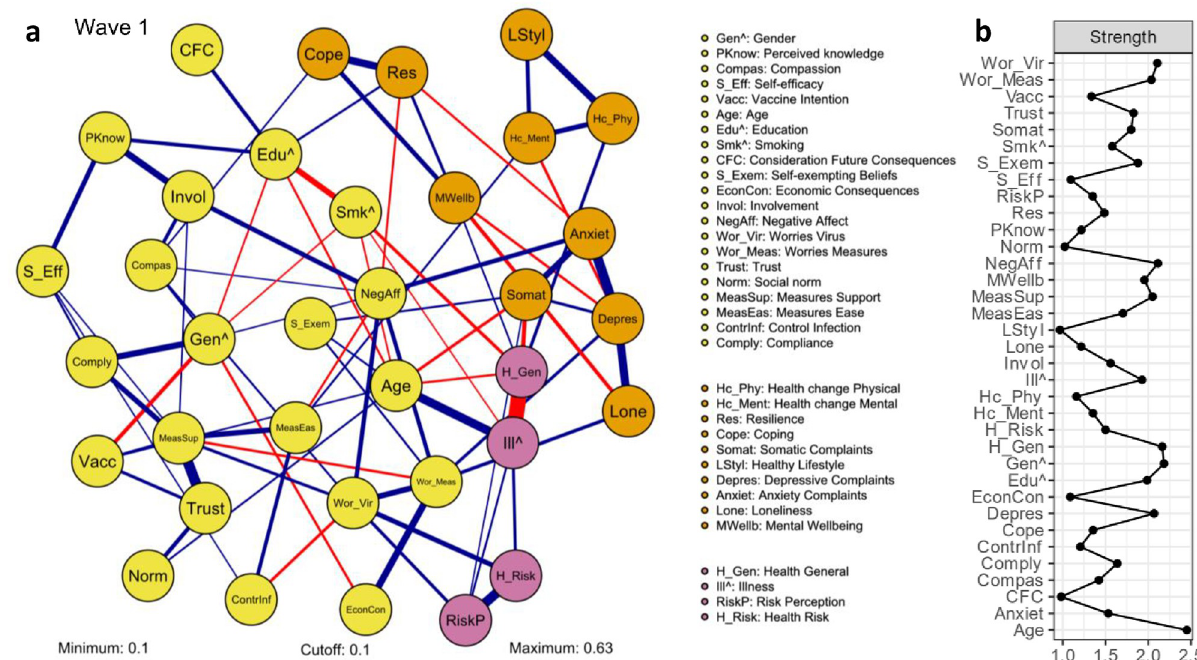
Fig 3. Psychological broad COVID–19 attitude network. a) Network obtained through nodewise regression, based on sample of participants that completed the first wave ( N = 6,093). Nodes represent the measured psychological factors and edges represent the relations between nodes. For binary nodes (marked with ^), a positive relationship indicates that increasing the other node results in a higher probability for category one of the binary node (i.e., Gender 1 = Female; Education 1 = Higher; Smoking 1 = Yes; Illness 1 = Yes). Positive edges (blue) represent excitatory relations and negative edges (red) represent inhibitory relations. The strength of the relation is indicated by the edge weight (visualized by edge width). Edges with edge weights below the value of .10 are omitted to facilitate readability. Colored groups represent communities (i.e., clusters with higher interconnectedness) consisting of nodes being more connected to each other than to other nodes in the network; b) Centrality measure ‘Strength’ for each node in the broad COVID–19 attitude network. This measure represents the conditional association between a node with other nodes in the network and is calculated by the sum of absolute edge weights of relations a specific node has with connected